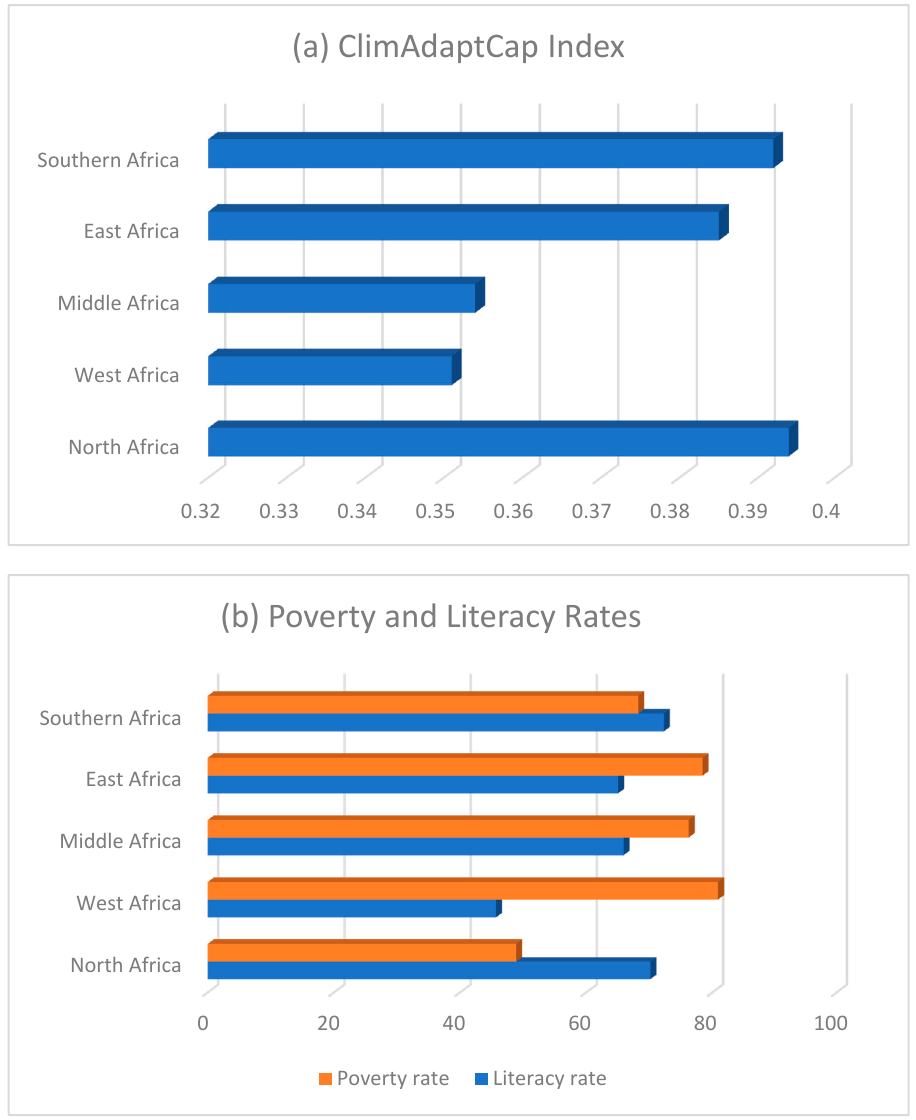
Figure 5. ( a ) ClimAdaptCap Indexes and ( b ) poverty and literacy rates across Africa. Source: author’s conceptualization.